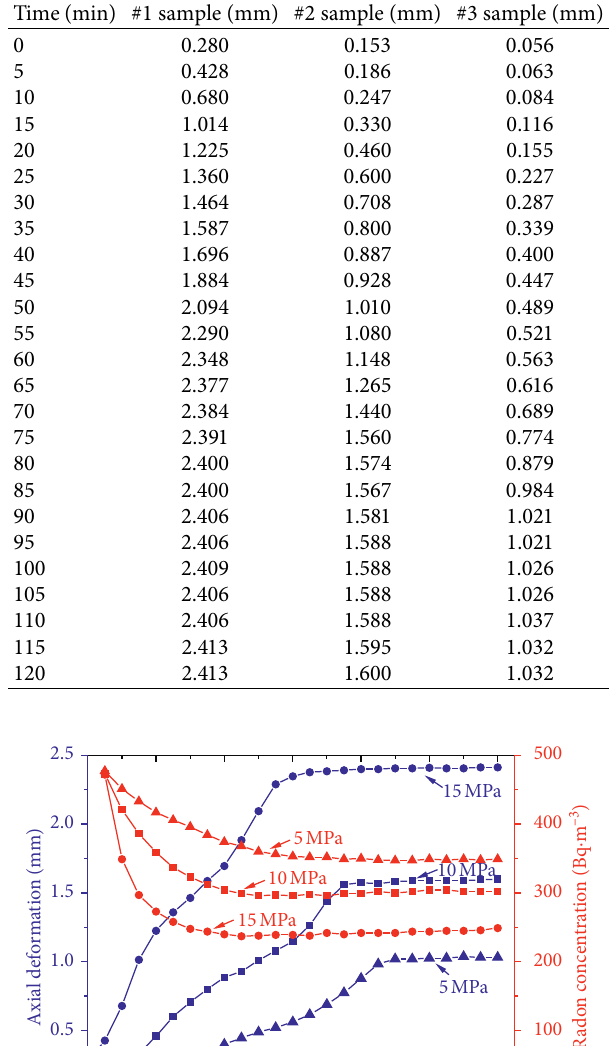
Table 2: The axial deformation of three